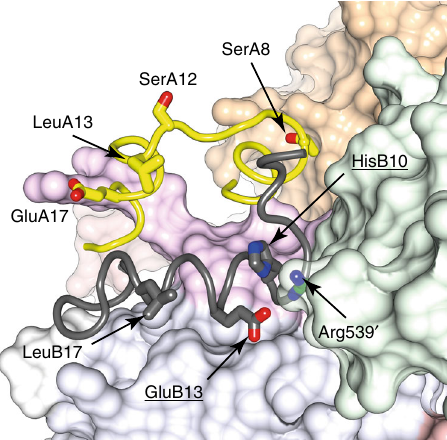
Fig. 6 Disposition of insulin residues deemed to bind the second site on the receptor surface. Insulin is shown in ribbon representation (A chain: yellow; B chain: gray) and the surrounding receptor domains in molecular surface representation (L1: light blue; CR: light pink, L2: light orange; FnIII-1 ′ : light green; α CT ′ : light magenta; N-linked glycan on domain L1: white). Insulin residues in stick representation are judged on the basis of alanine scanning mutagenesis 20,23 to be involved in insulin ’ s interaction with its secondary binding site on the receptor surface. Of these, only His B10 and GluB13 (underlined labels) interact here with the receptor. Also shown is receptor residue Arg539 ′ that likely interacts with the carboxylate side chain present at position B10 in Asp/GluB10 mutant insulins (see Results for